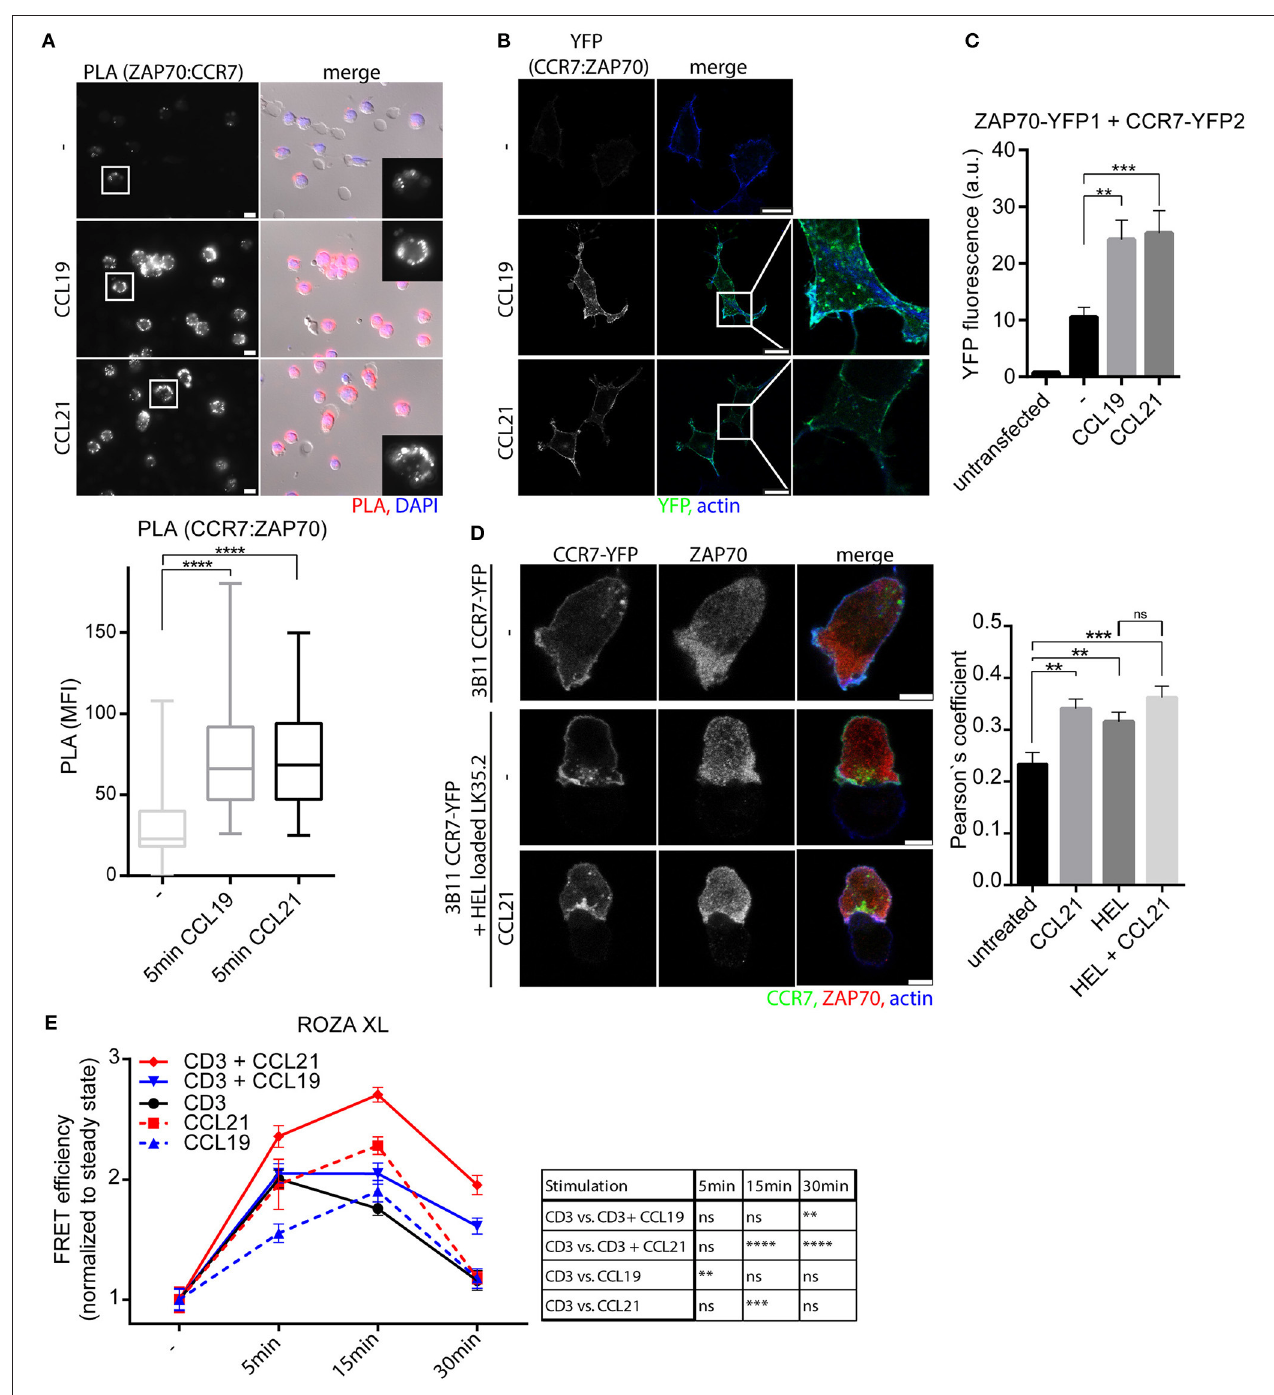
FIGURE 2 | CCR7 triggering recruits and activates ZAP70. (A) Micrograph and quantification (box and whisker plot, n > 50 cells) of CCR7-ZAP70 interaction in human PBLs stimulated or not with 0.5 µ g/ml CCL19 or CCL21 for 15min assessed by PLA. Representative epifluorescence images derived from one donor out of three; scale bar, 10 µ m. (B) Confocal images of CCR7-YFP2:ZAP70-YFP1 interaction determined by BiFC in transfected HEK293 cells stimulated or not with 0.5 µ g/ml CCL19 or CCL21 for 1h. One experiment out of three; scale bars, 25 µ m. (C) Quantification of CCR7-YFP2:ZAP70-YFP1 interaction by BiFC assessed by flow cytometry after 1h stimulation with 0.5 µ g/ml CCL19 or CCL21. Mean ± SEM of five independent experiments. (D) Confocal images and quantification (Pearson’s coefficient, n > 15 cells) of the co-localization between CCR7-YFP and ZAP70 in 3B11T cells stimulated or not with 0.5 µ g/ml CCL21 for 1h either alone or conjugated with HEL peptide-loaded LK35.2 APCs. Representative images derived from one of three independent experiments; scale bar, 5 µ m. (E) Quantification of ZAP70 activation determined by FRET efficiency of the ROZA-XL FRET biosensor in Jurkat T cells upon CCR7 and/or TCR stimulation [5 µ g/ml anti-CD3 (clone OKT3)]. Mean ± SEM of 10 cells per condition derived from one out of three independent experiments. ** p < 0.01; *** p < 0.001; **** p < 0.0001. ns, not significant.